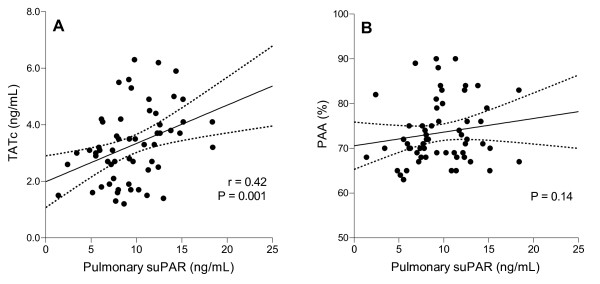
Correlations between levels of soluble urokinase-type plasminogen activator receptor (suPAR) and coagulopathy. Analyses of the correlation between pulmonary levels of suPAR and parameters of (a) pulmonary coagulation and (b) fibrinolysis. Linear correlations with 95% confidence intervals are shown. Pearson correlation coefficients (r) and P values are given in each panel.